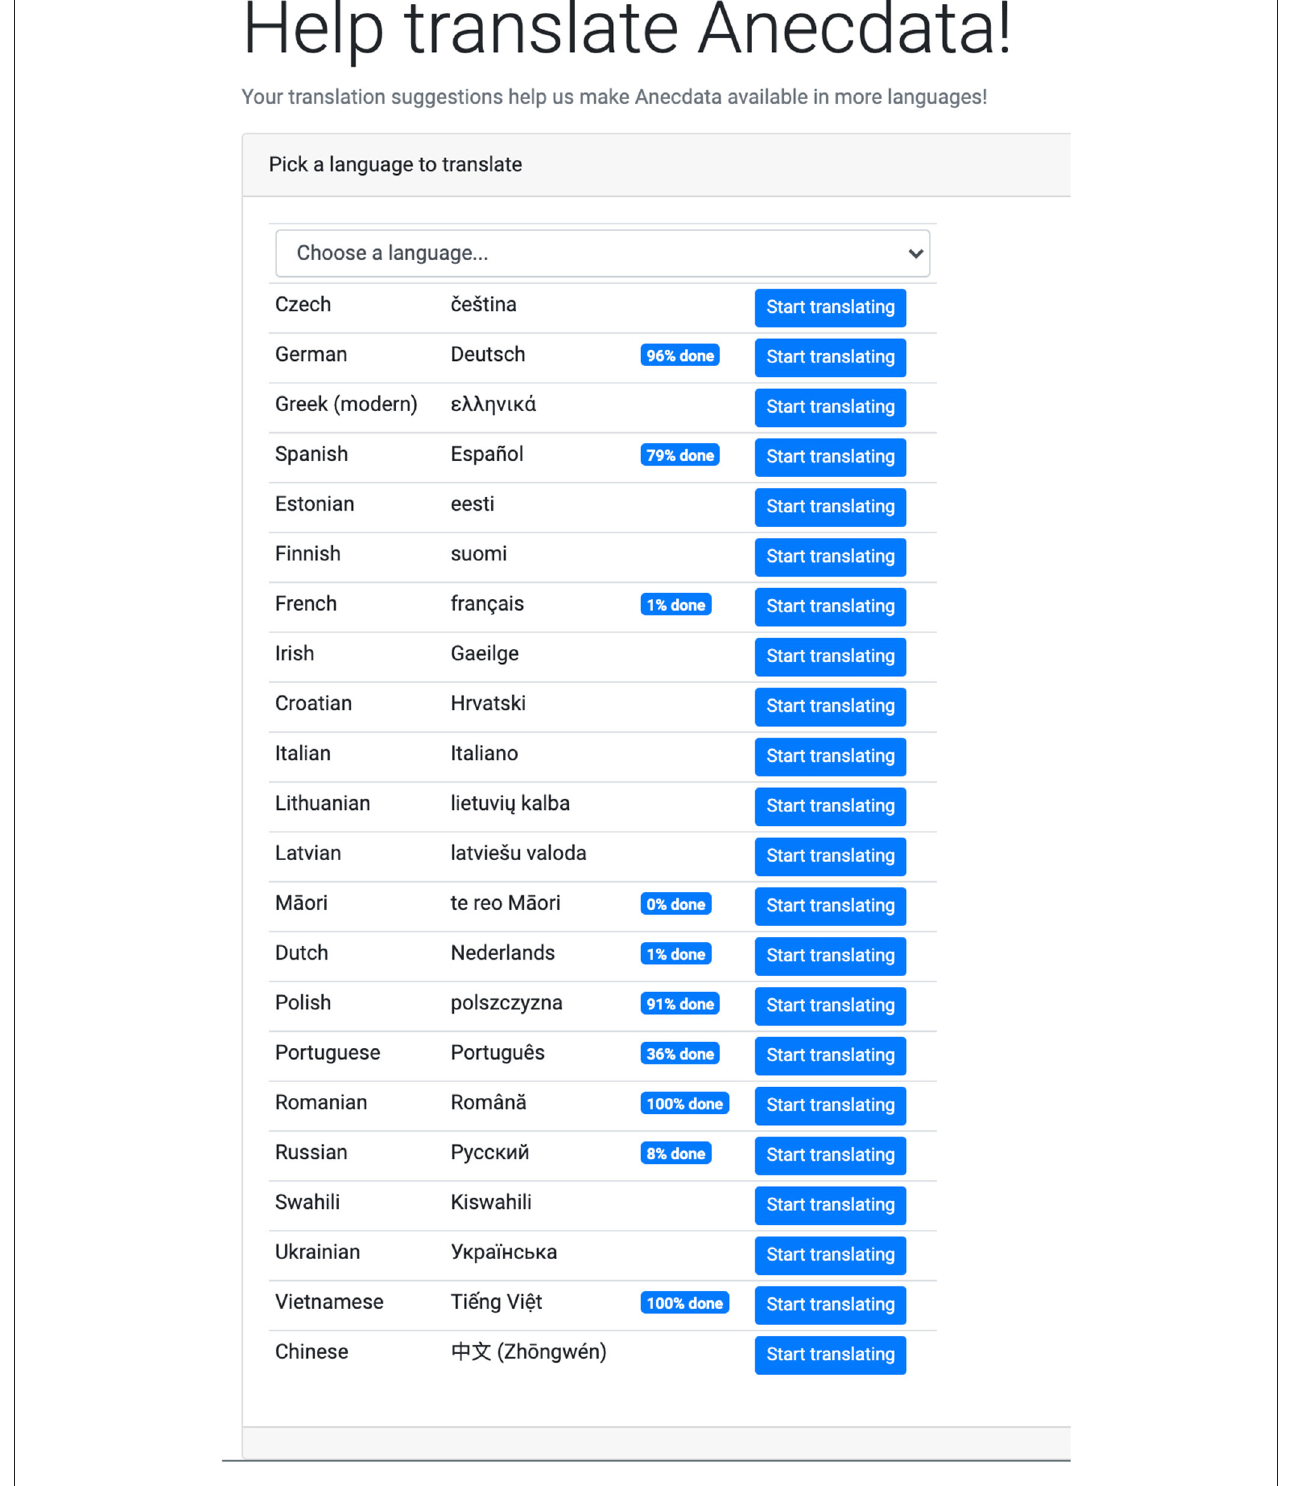
FIGURE 9 | Translating Anecdata to promote findability, accessibility, interoperability, and reusability (FAIR) principles. Anecdata users are invited to help translate data into any of 22 languages.